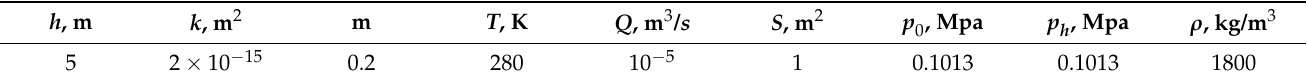
blowout occurs as the gas pressure exceeds the overburden pressure.